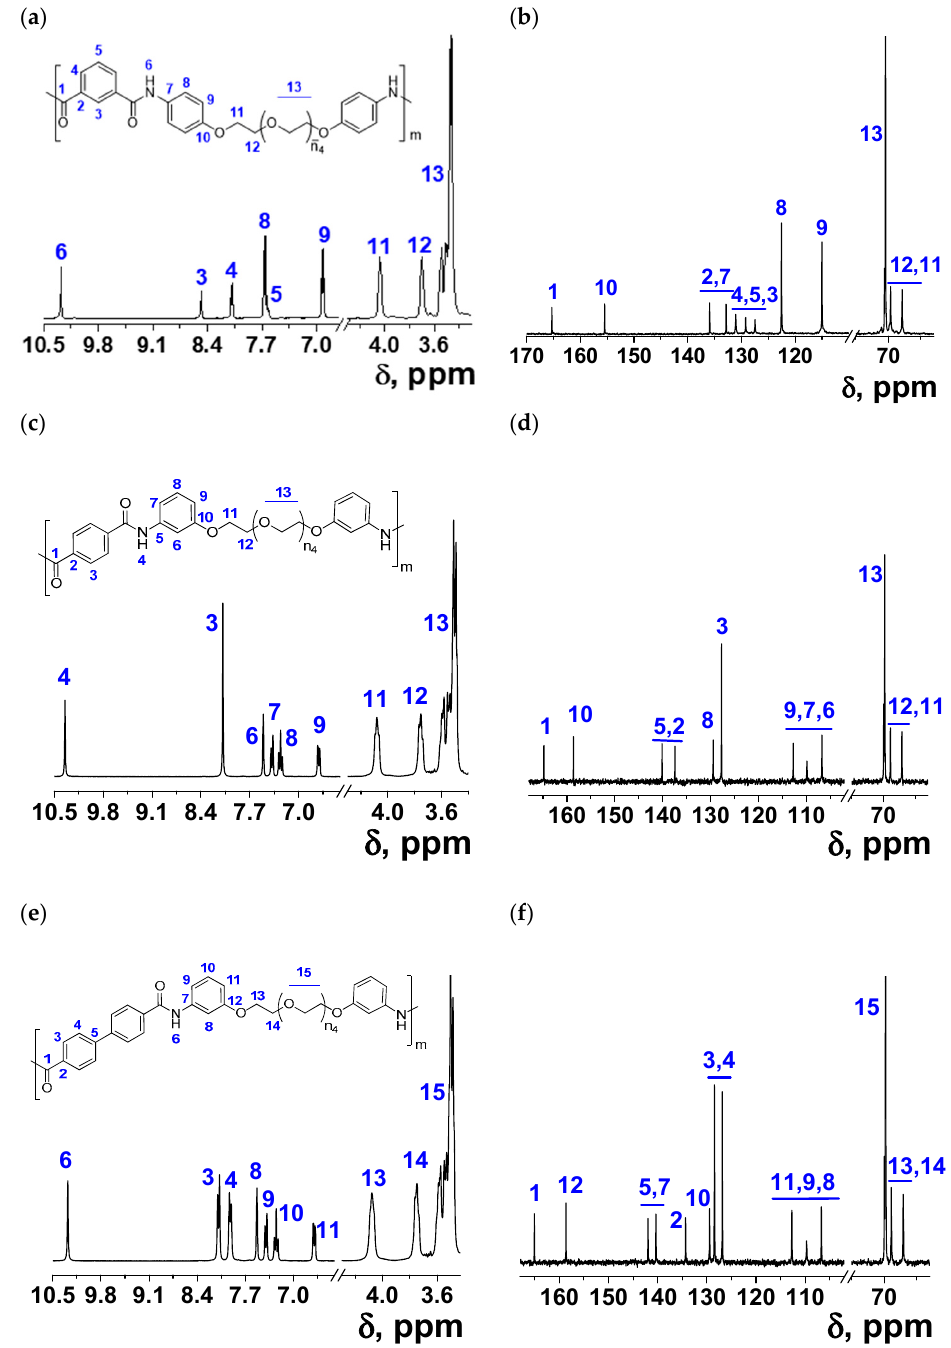
Figure 2. NMR spectra of IPCP-A (n 4 + 1 = 8.22) ( a ) 1 H NMR and ( b ) 13 C NMR; NMR spectra of TPCM (n 4 + 1 = 8.22) ( c ) 1 H NMR and ( d ) 13 C NMR; and NMR spectra of DBCM (n 4 + 1 = 8.22) ( e ) 1 H NMR and ( f ) 13 C NMR.